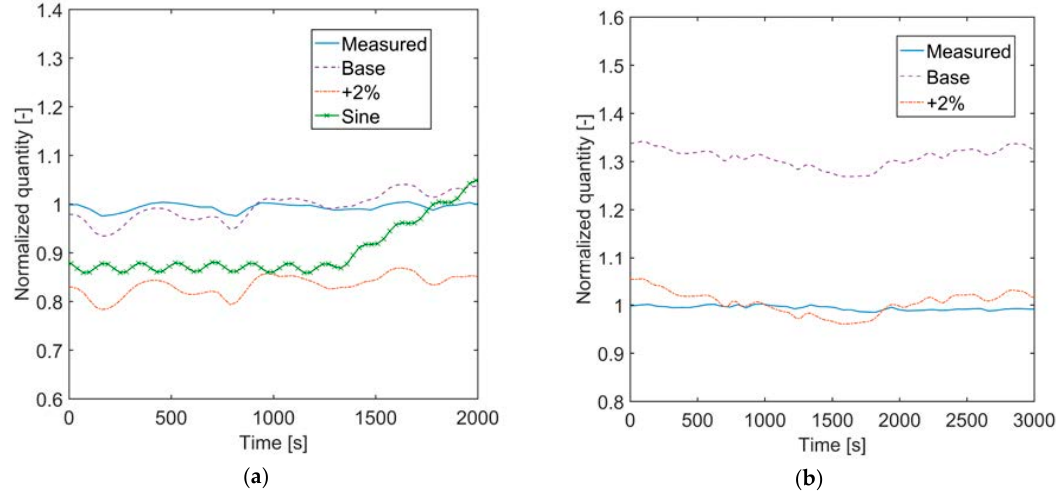
Figure 14. Measured and simulated liquid level for ( a ) Case 1; and ( b ) Case 2. “Base” refers to the thermal brine inlet volume flow rate as measured, whereas “+2%” to increase of the latter of 2%. “Sine” refers to a sinusoidal inlet mass flow rate of organic fluid. (HF: Heating fluid, WF: working fluid).